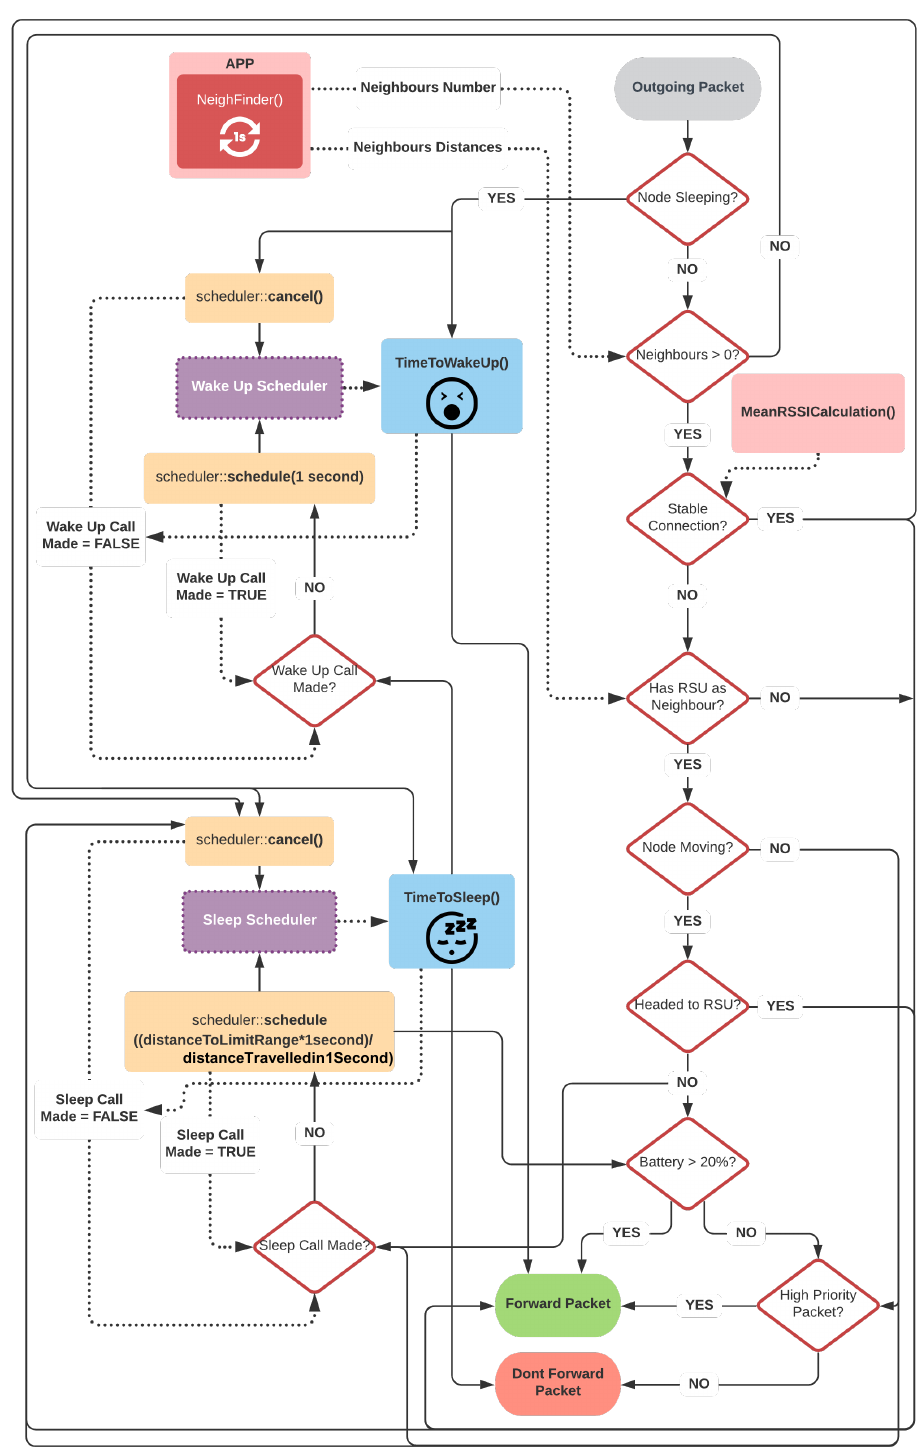
Figure 7. Packet forwarding decision